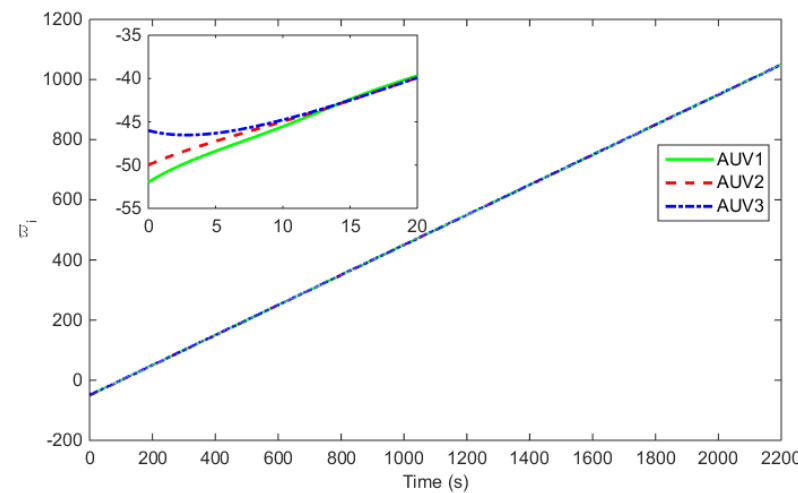
Figure 9. Path parameter variables of three AUVs.